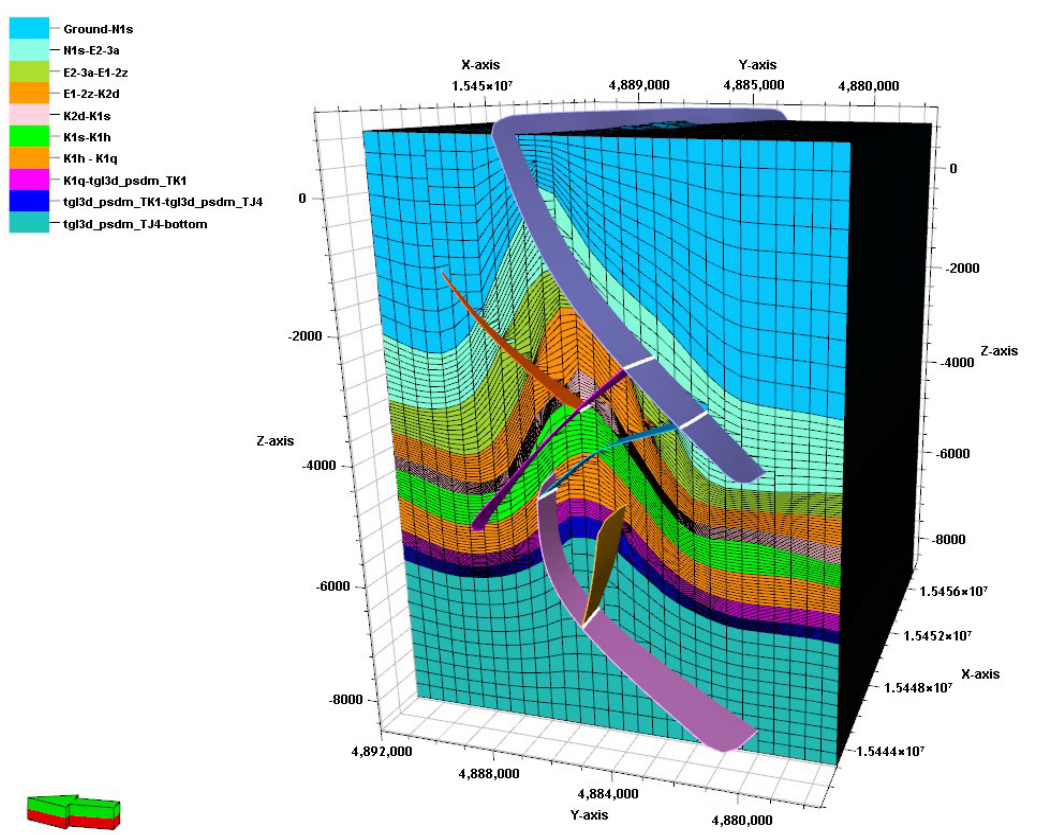
Figure 5. Geological structure model of the TS block.